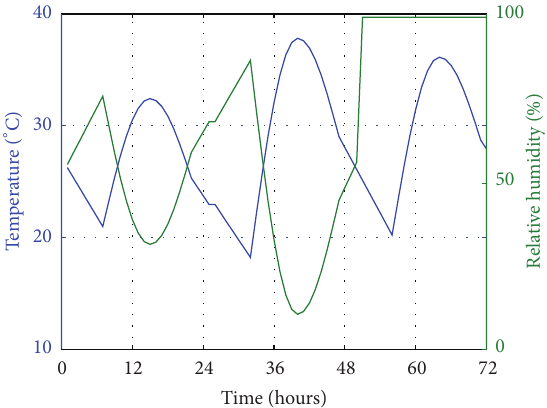
Figure 4: Simulated air temperature and humidity for three days, with rain in the third day, for the month of